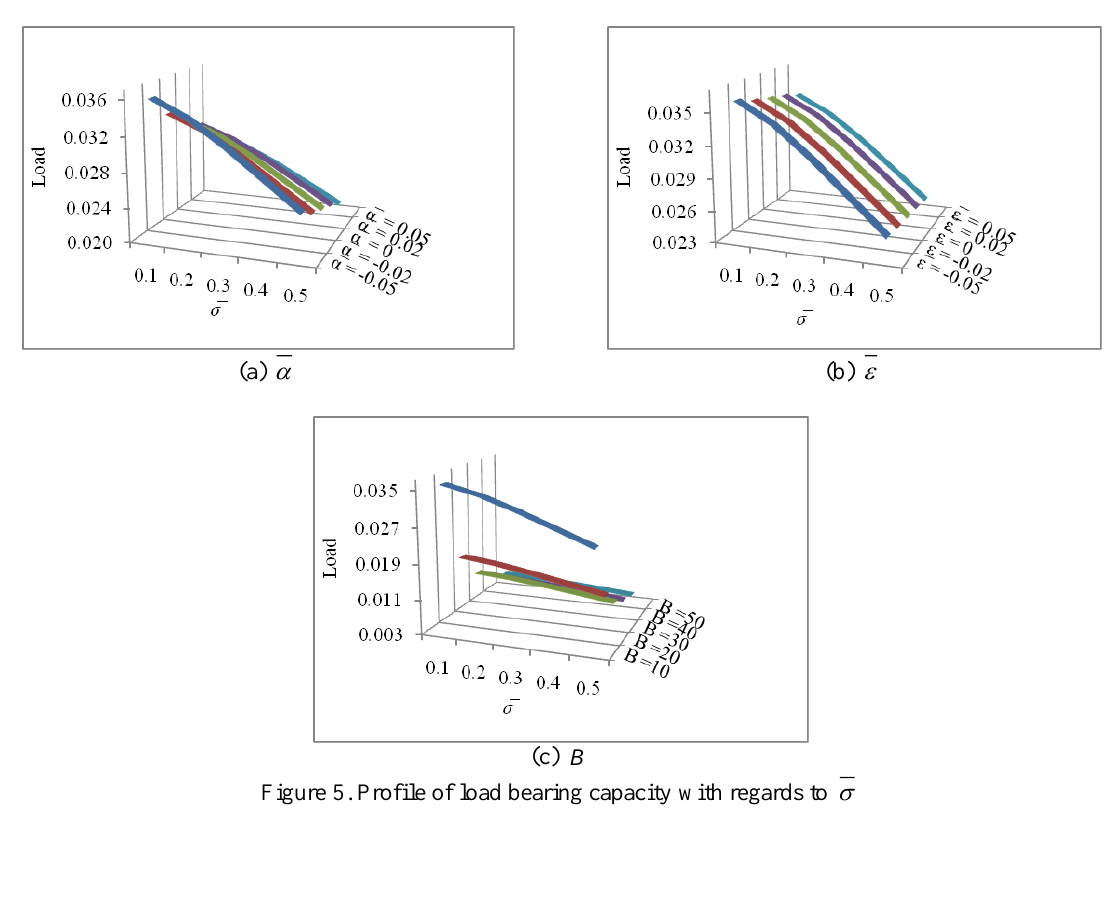
Figure 5. Profile of load bearing capacity with regards to 